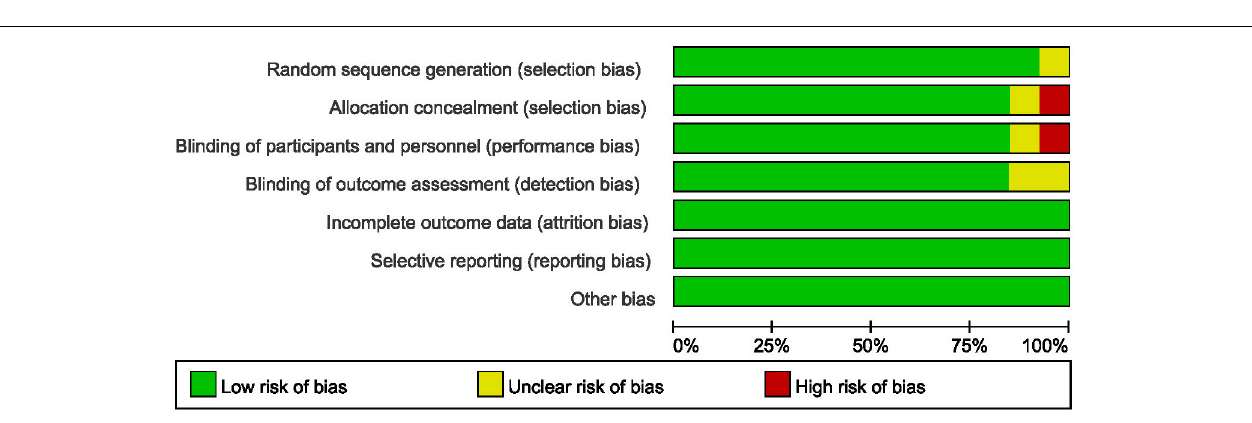
FIGURE 2 | Risk of bias